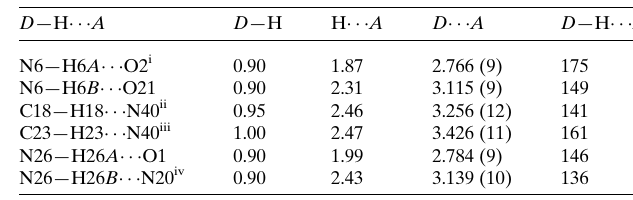
Table 1 Hydrogen-bond geometry (A˚ , (cid:3) ).